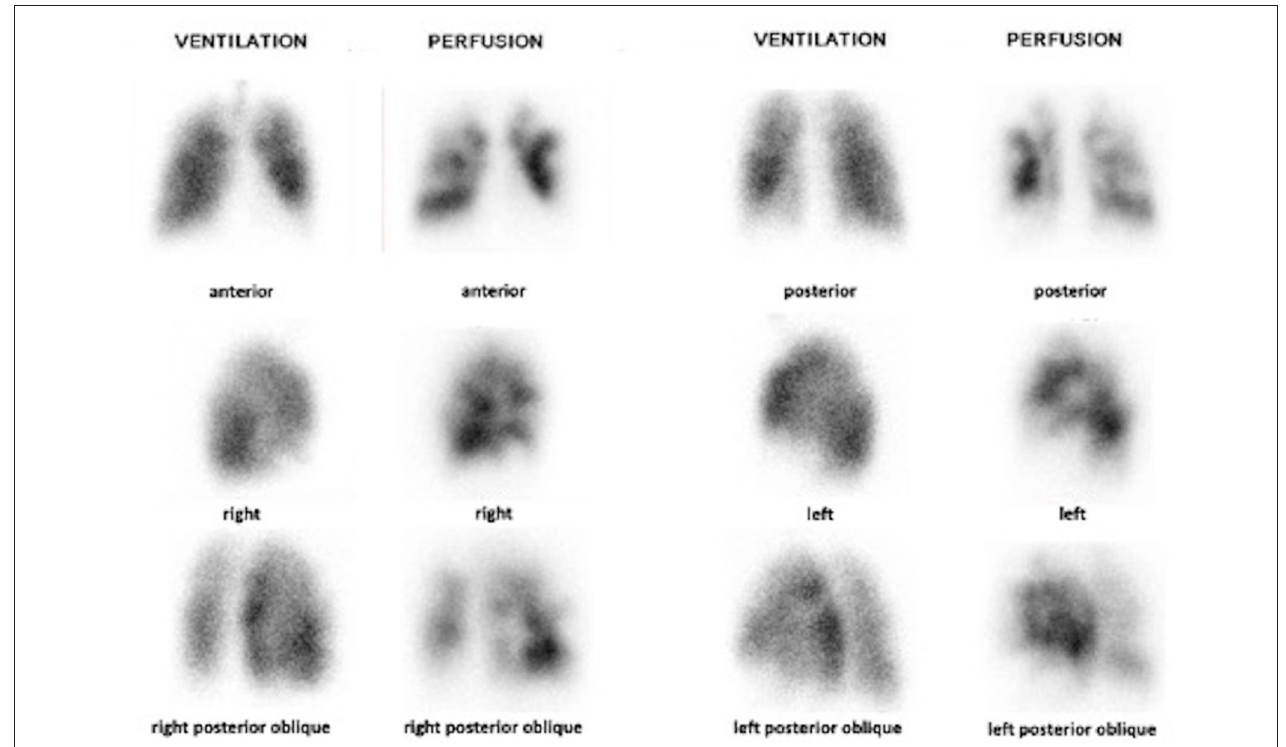
FIGURE 1 | Planar V/Q scintigraphy showing multiple segmental mismatched perfusion defects in a patient with confirmed CTEPH.